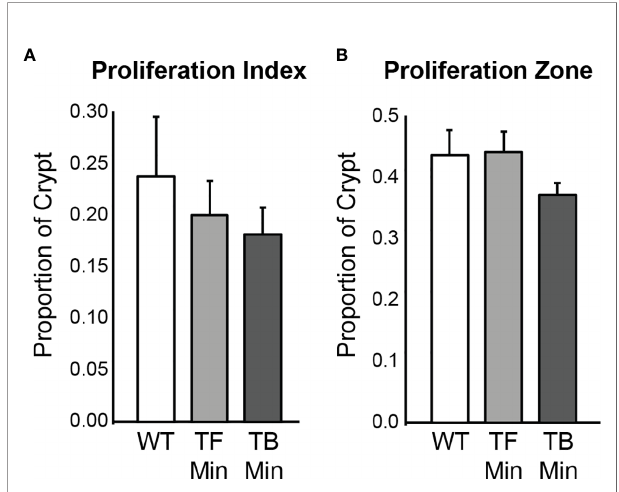
FIGURE 5 | Epithelial cell proliferation in the distal colon of Apc +/+-FCCC wild type mice ( ‘ WT ’ ; n=4), tumor-free Apc +/Min-FCCC mice ( ‘ TF Min ’ ; n=6) and tumor-bearing Apc +/Min-FCCC mice ( ‘ TB Min ’ ; n=6). Bars represent mean ± S.E.M. (A) Fold change in proliferative index in tumor-bearing vs tumor-free mice = 0.9; Welch ’ s t-test p = 0.65. (B) Fold change in size of the proliferative zone in tumor-bearing vs tumor-free mice = 0.8; Welch ’ s t-test p = 0.15.